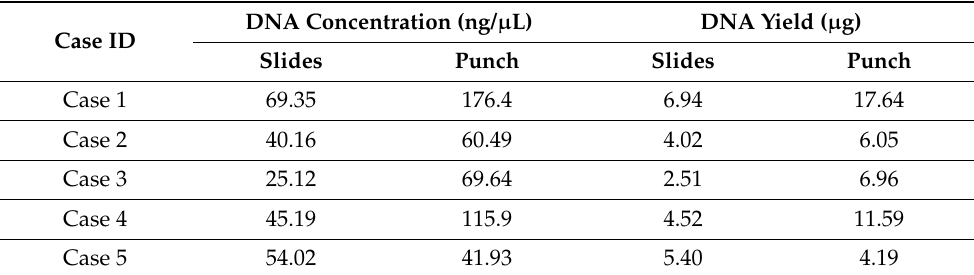
Table 3. Comparison of DNA concentration and yield from FFPE 3 mm core and unstained